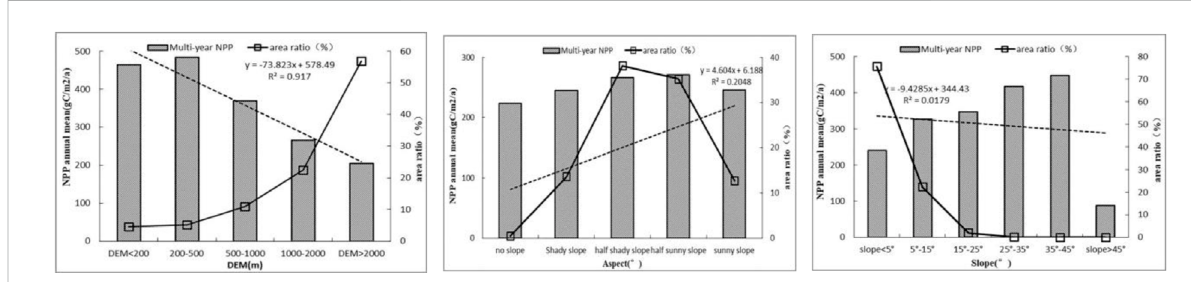
FIGURE 9 RelationshipbetweentopographicfactorsandgrasslandNPP. (A) ChangesintherelationshipbetweenannualNPPandDEM. (B) Changesinthe relationship between annual NPP and Aspect. (C) Changes in the relationship between annual NPP and Slope.